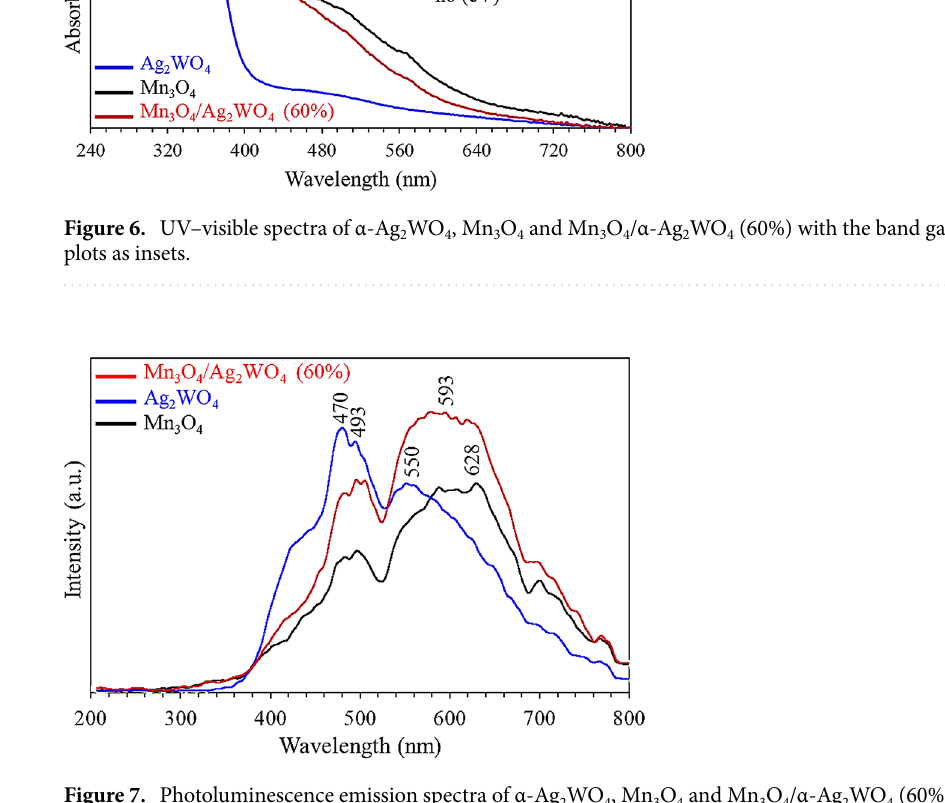
Figure 7. Photoluminescence emission spectra of α-Ag 2 WO 4 , Mn 3 O 4 and Mn 3 O 4 /α-Ag 2 WO 4